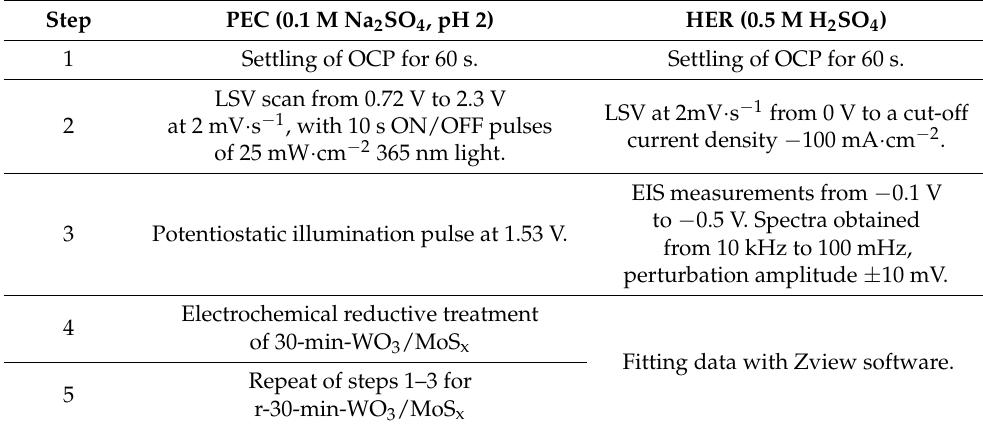
Table 1. Outline of experiments used to characterize the PEC and HER properties of synthesized catalysts. Potentials were recalculated vs.